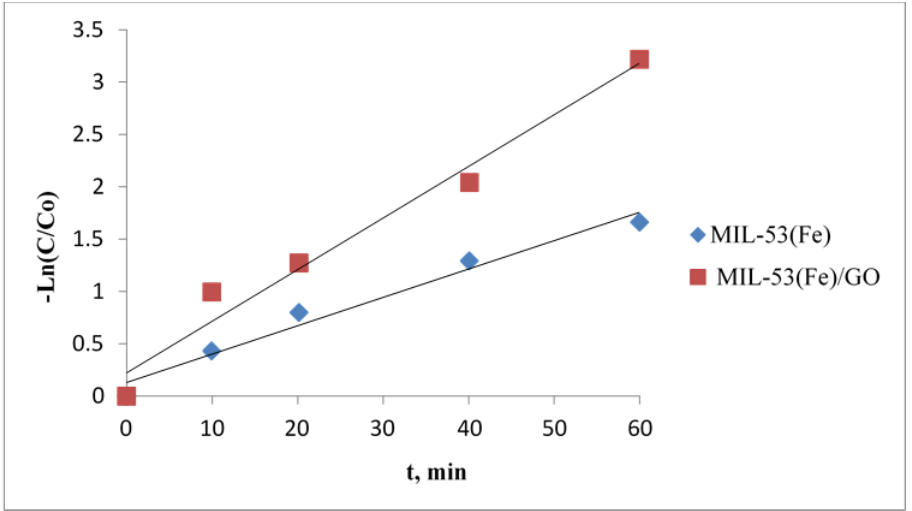
Figure 13. Results of the reaction with red reactive195 (RR195) in aqueous medium compared with UV irradiation time in the presence of MIL-53(Fe) and MIL-53 (Fe)/GO.